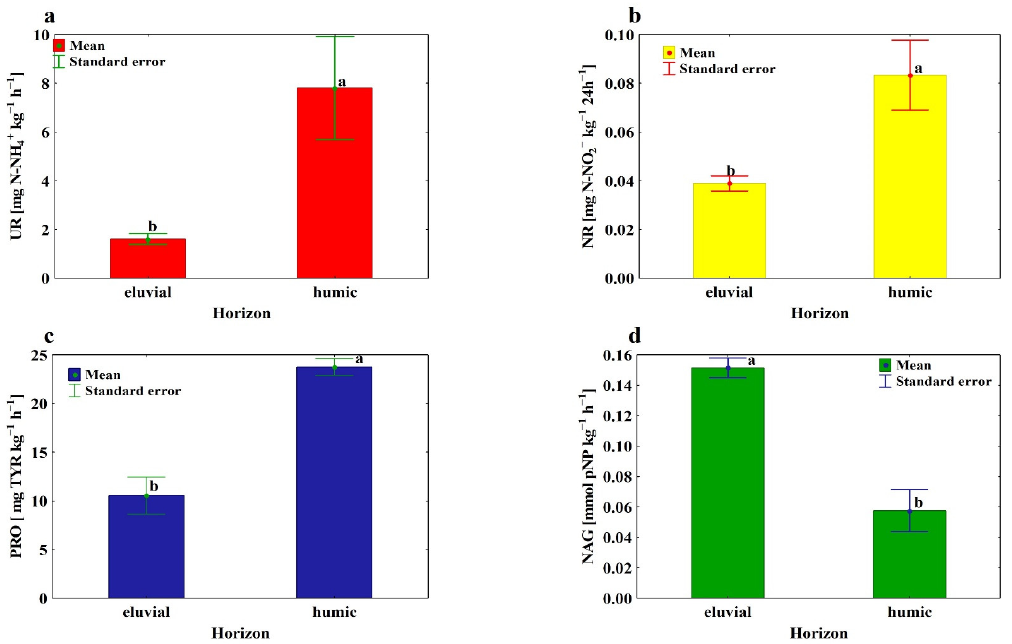
Figure 2. Effect of the lessivage process on the potential UR ( a ), NR ( b ), PRO ( c ), NAG activity ( d ); whereas eluvial horizons refer to the E1 and E horizons in the profiles 1 and 3, while humic horizons refer to the A2 and BCkg horizons in the profiles 2 and 4 (mean ± SE). Values in compared horizons followed by different small letters are statistically different at p <